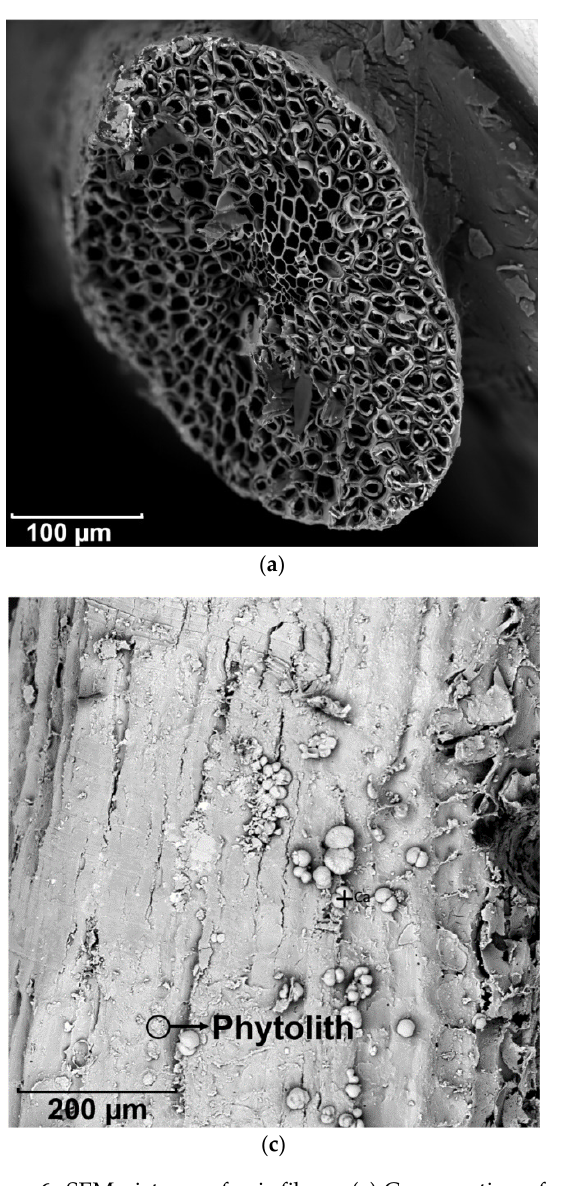
Figure 7. Water permeable porosity of LWAC with coir fibers of various contents and different treatments on 7 days and 28 days, calculated from the measured mass changes. The SEM micrographs of ITZs between both raw and pretreated coir fibers and ma- trix are shown in Figure 8. It can be seen that fiber treatments have a positive effect on the ITZs. The ITZs of the raw fibers are usually porous, and cracking along the fibers can be observed. This is caused by the heterogeneity of fibers and cement resulting in weak ITZs, which are in favor of cracks propagating. Another explanation can be the desiccation